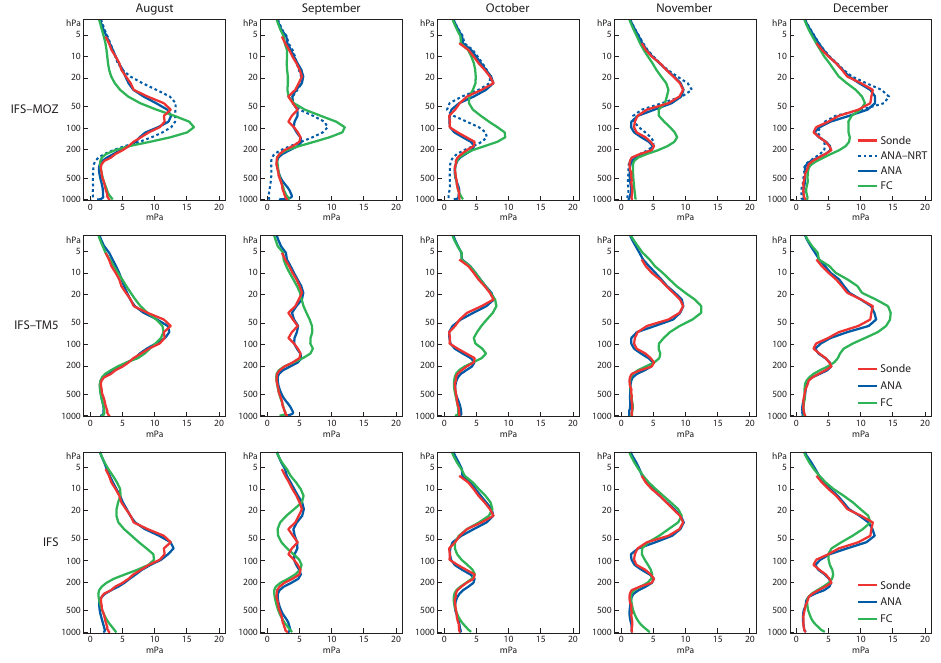
Fig. 10. Monthly averaged ozone profiles (partial pressure in mPa) forecast by IFS-MOZART (top), by IFS-TM5 (middle) and by IFS (bottom) without assimilation (FC, green), with assimilation (ANA, blue), with assimilation but excluding MLS data (ANA ∗ , blue dotted line, IFS-MOZART only), and observations (Sonde, red) at Neumayer Station from August to December